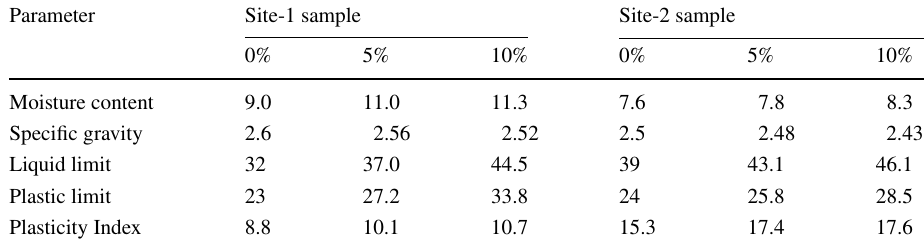
Table 3 Soil physical